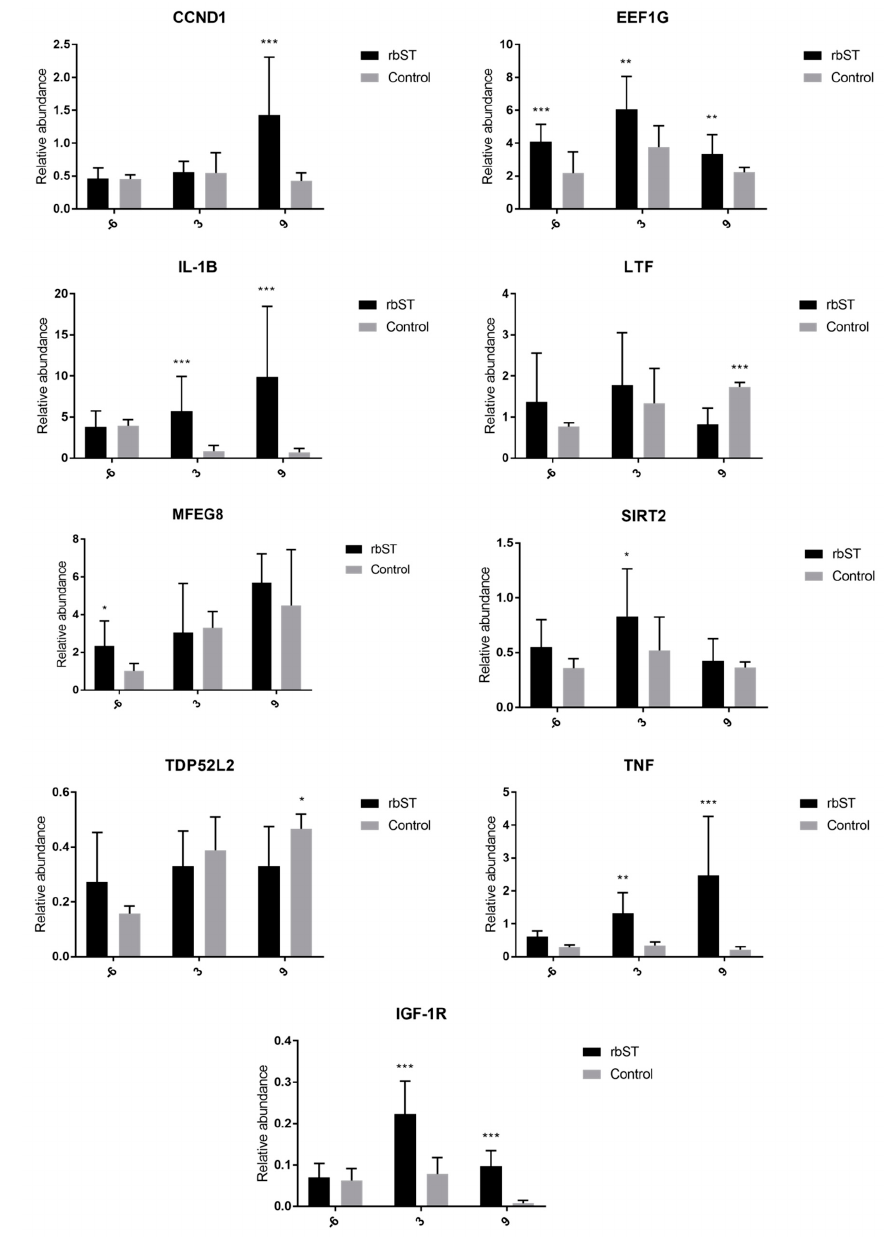
Figure 3. Relative abundance of target genes expressed in milk somatic-cell samples before rbST administration, and on the third and ninth days after rbST administration. The bars represent the mean value of each group (rbST and control). The value used for each animal is the mean of three replicates. * p < 0.05, ** p < 0.01, *** p <